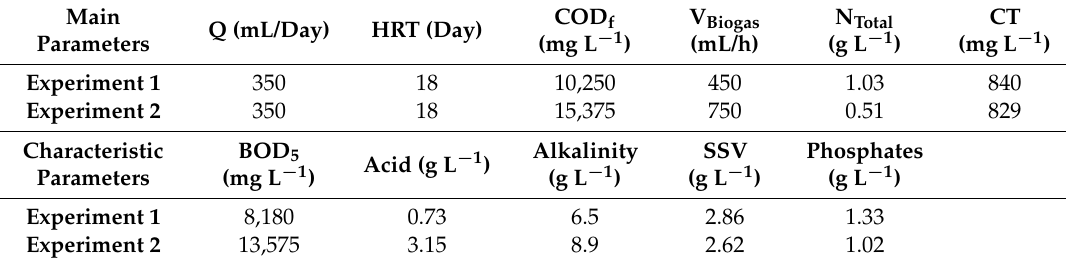
Table 8. Final values of the main parameters and the characteristic parameters for the different experiments, where Q is the flow rate (mL/day), HRT is the hydraulic residence time (day), COD f is the chemical oxygen demand (mg/L), V Biogas is the volume of biogas (mL/h), N Total is the